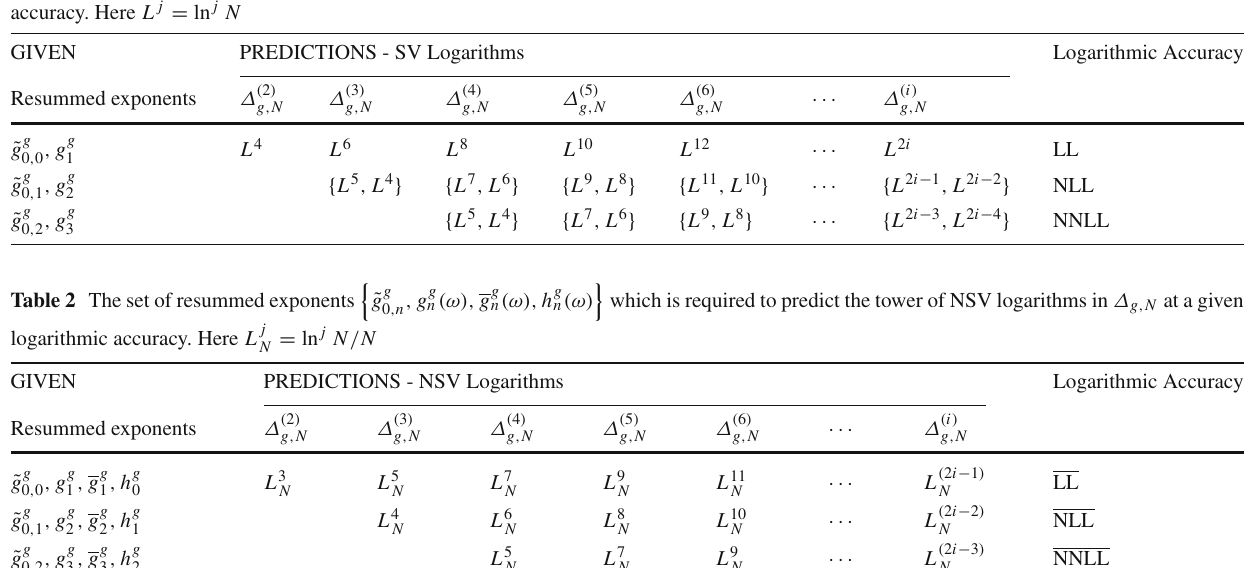
(cid:17) (cid:16) , g g (ω) ˜ g g which is required to predict the tower of SV logarithms in Δ g , N at a given logarithmic n 0 , n